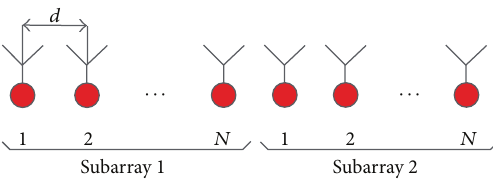
Figure 1: Illustration of transmit subaperturing FDA